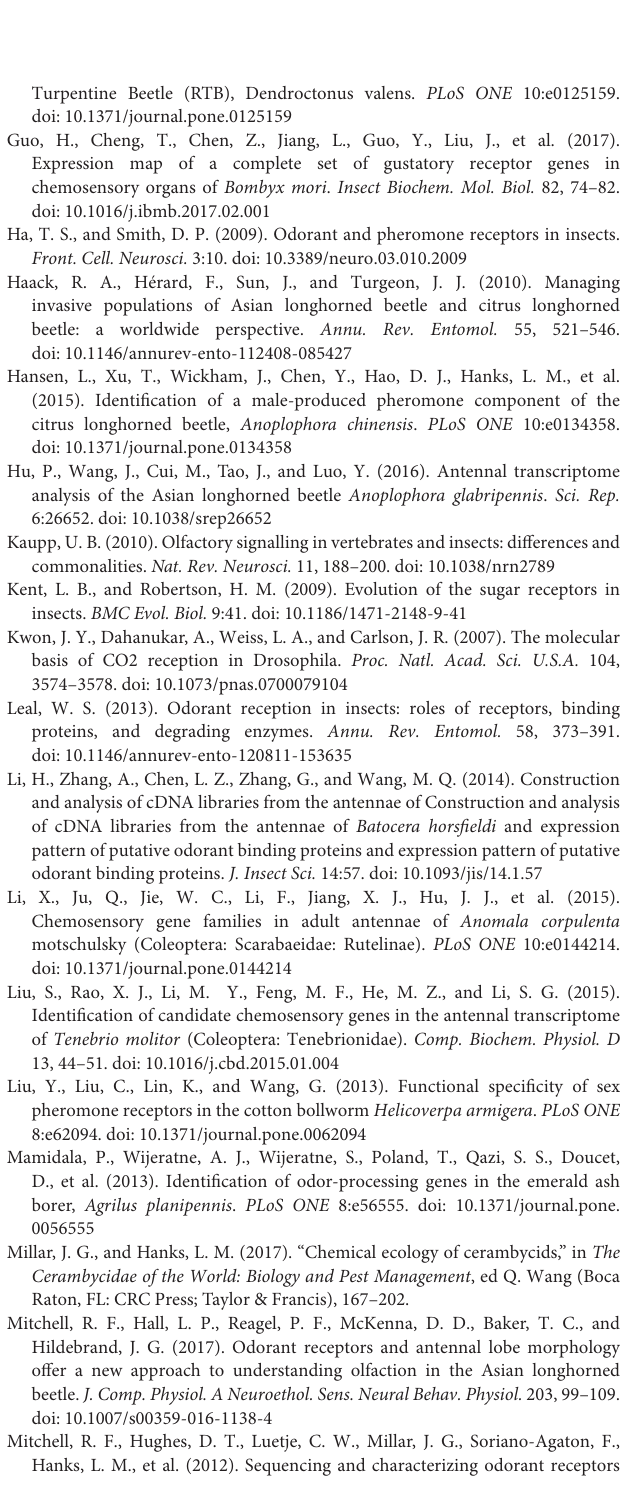
Table S3 | Comparative overview of Anoplophora chinensis chemosensory receptor genes idenetified in this study and in Wang et al. (2017) study. Table S4 | Comparative overview of Anoplophora chinensis chemosensory receptor genes identified in this study and Anoplophora glabripennis chemosensory receptor genes reported in Hu et al. (2016) study.